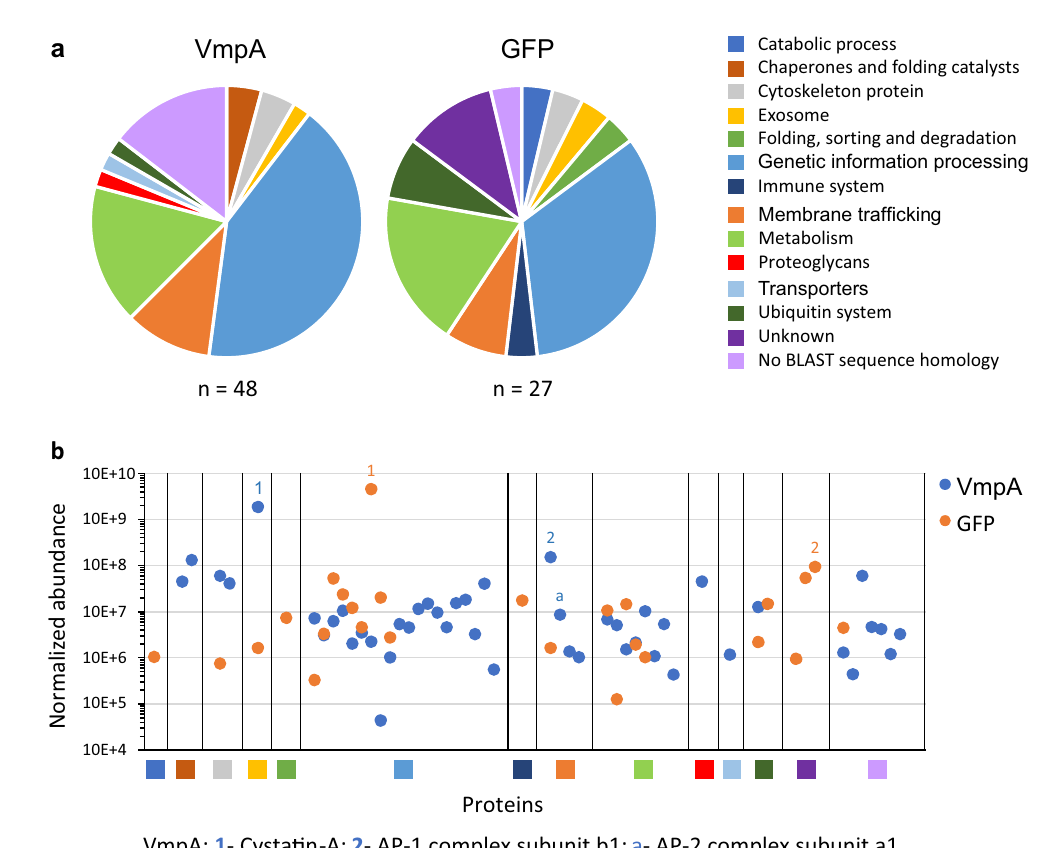
Figure 1. Distribution of proteins interacting with VmpA or GFP after pull-down purification and LS-MS/MS identification. The proteins that significantly interacted more with VmpA than with GFP (VmpA) or more with GFP than with VmpA (GFP) were classified in function of the KEGG BRITE classification ( a ) or represented in function of their normalized abundance ( b ). The two proteins with the highest abundance identified for each condition are indicated in the graph and named under the